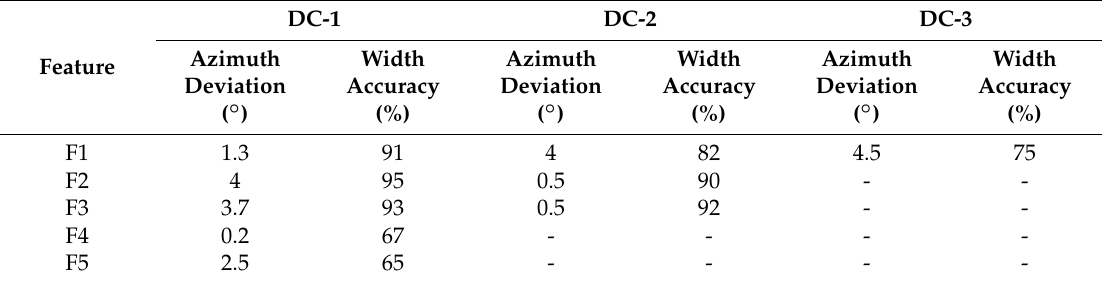
Table 4. Results of vein extraction validation for selected features (Figure